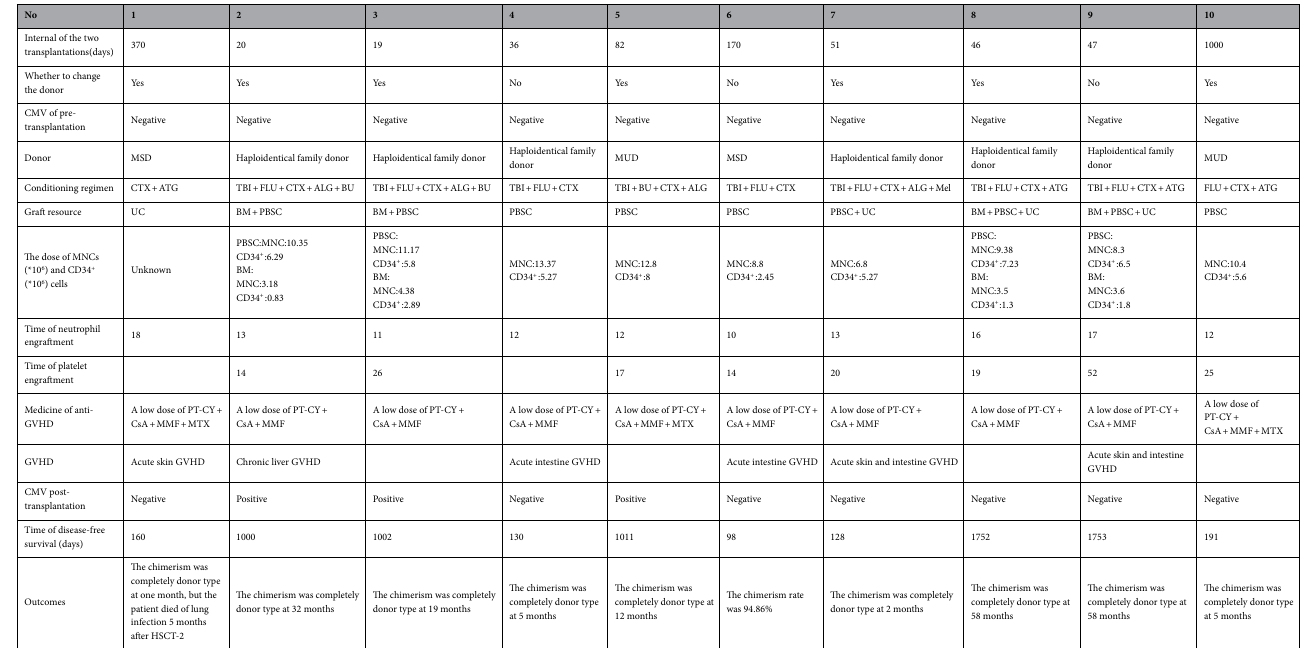
Table 2. The information of the pediatric patients of